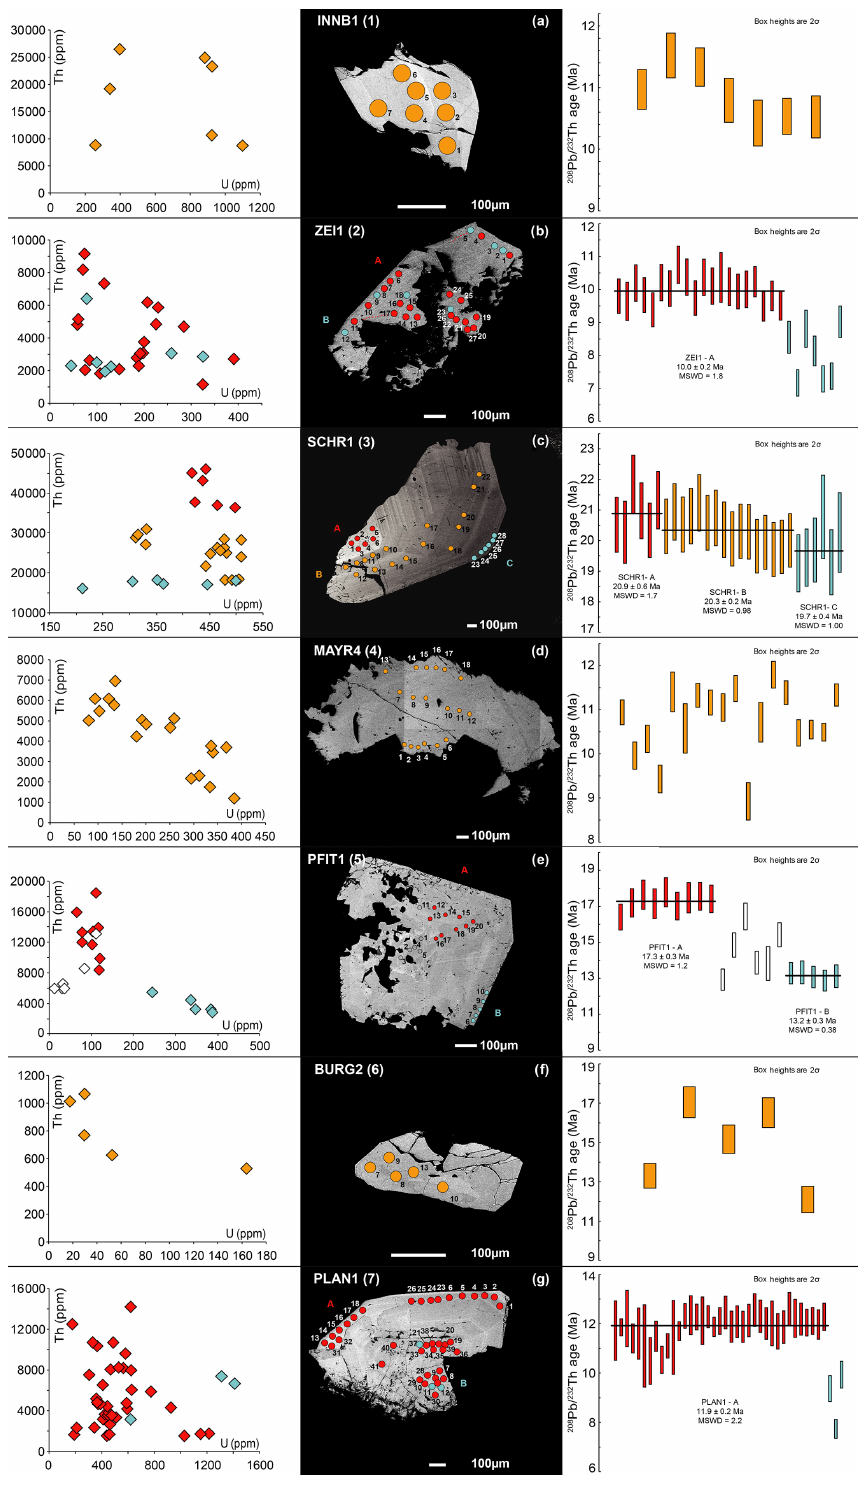
Figure 3. Chemical, textural and geochronological information of monazite grains from the western TW. On BSE images, colour-filled circles correspond to ion probe spot locations. Note that the square-shape shading in grain 4 is due to an artefact of composing BSE images with diverse